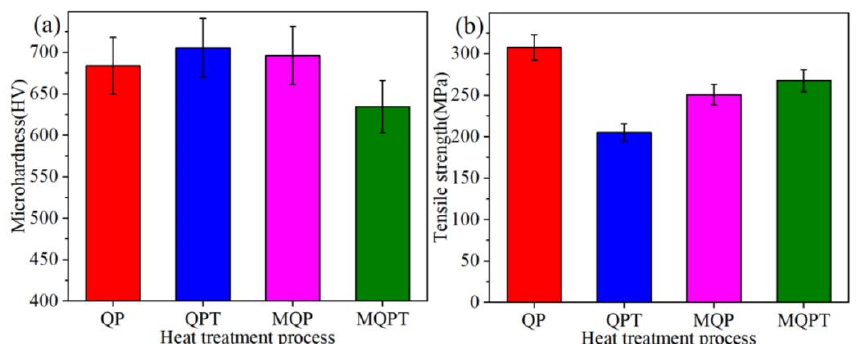
Figure 4. Microhardness ( a ) and tensile strength ( b ) of the VCFC with different heat-treated processes.